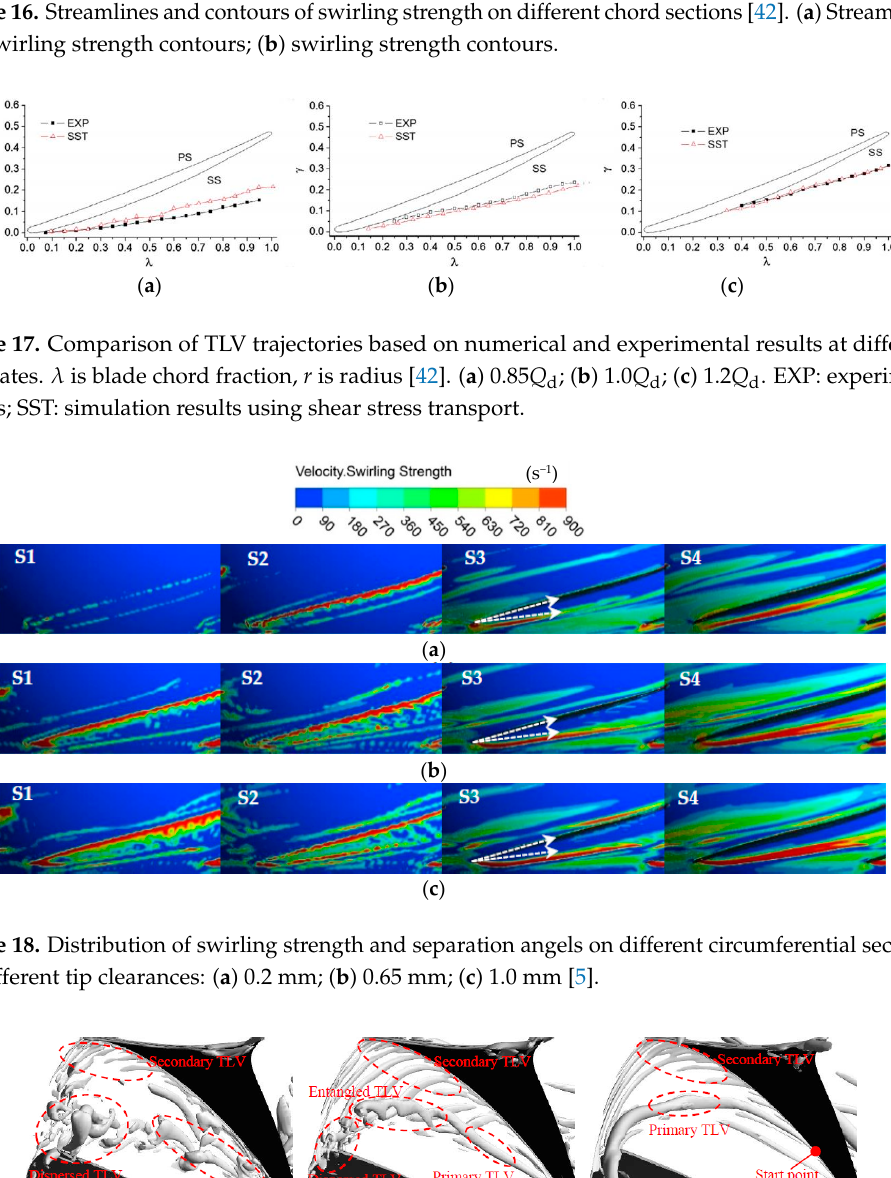
Figure 19. Vortex structure defined by Q criterion for three flow rates [43]. ( a ) 0.8 Q ; ( b ) 1.0 Q ; ( c ) 1.2 Q .